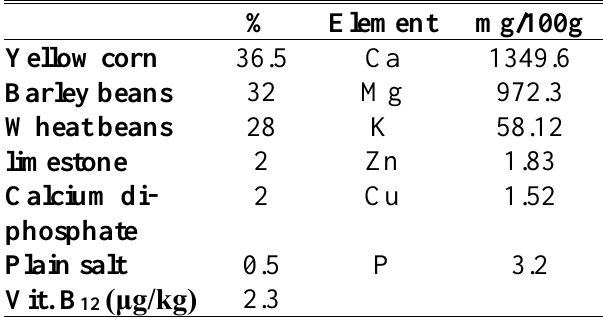
Table1. Composition of basal diet and analysis of the experimental